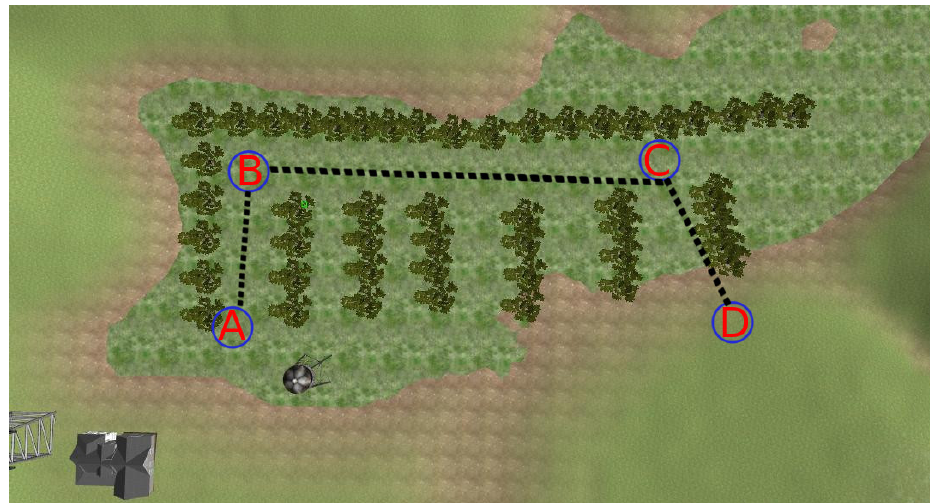
Figure 12. Insect trap poses ( A – D ) and paths generated by the RRT path-planning algorithm linking them.